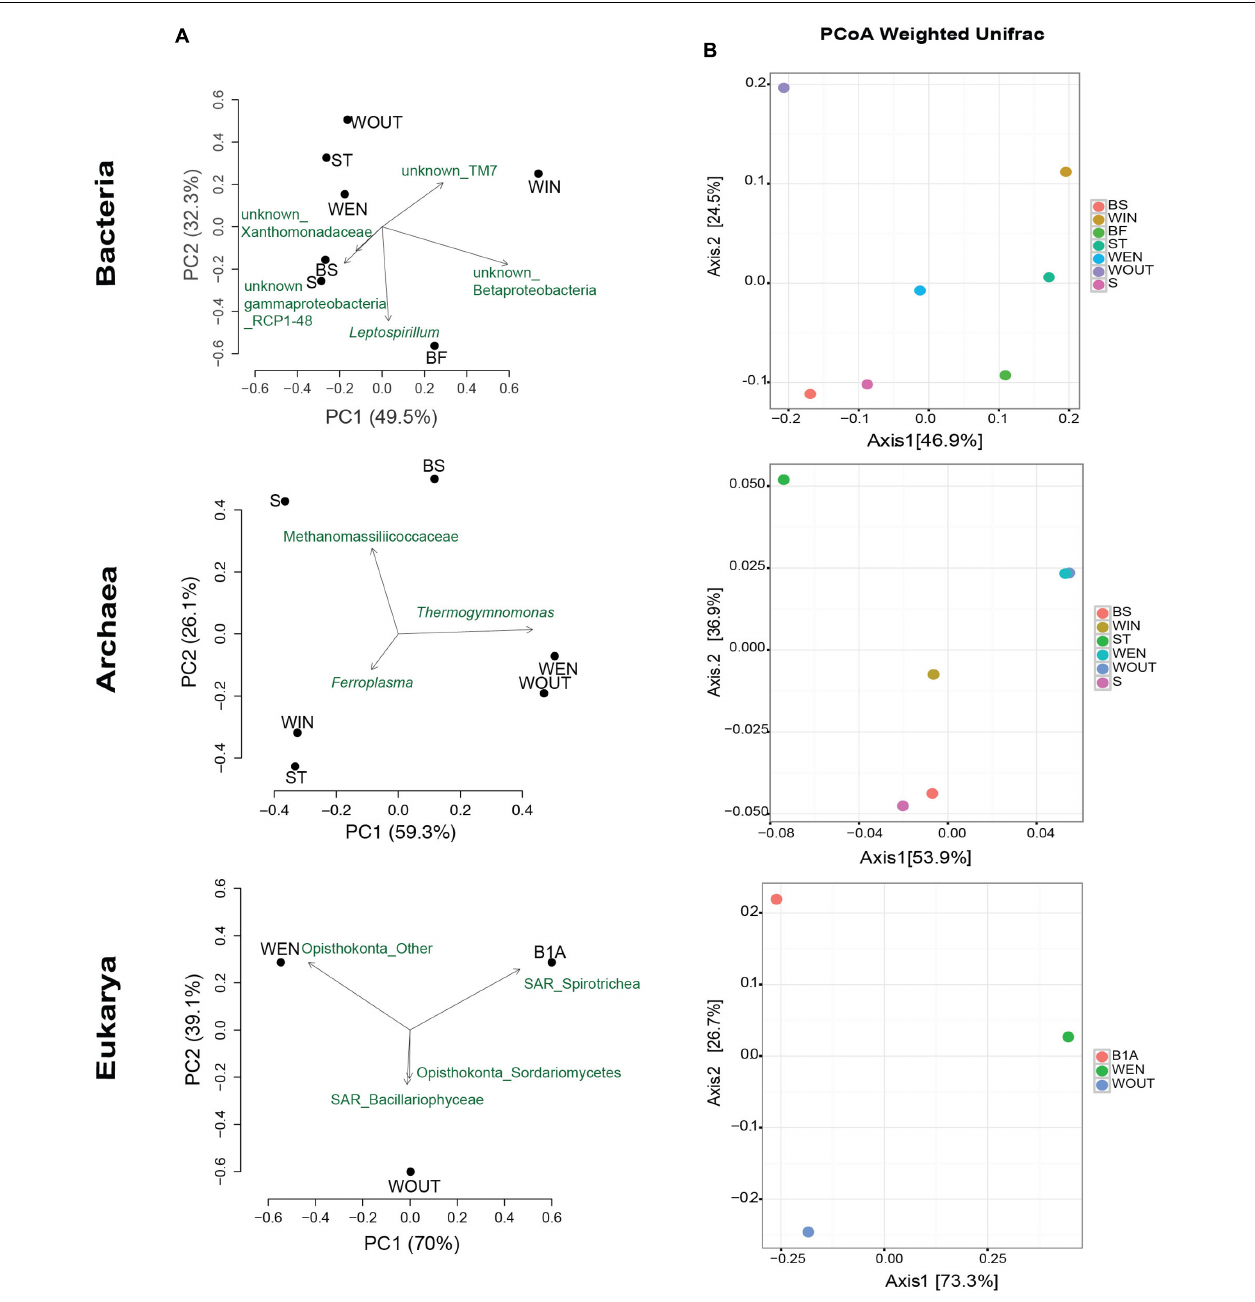
FIGURE 5 | Principal coordinates analysis (PCoA) based on the weighted UniFrac distance metric for Bacteria, Archaea, and Eukarya. PCoA on the phylogenetic distances among samples revealing the main taxa contributing to differences in their microbial diversity (A) . PCoA to visualize similarities in the microbial composition (B)